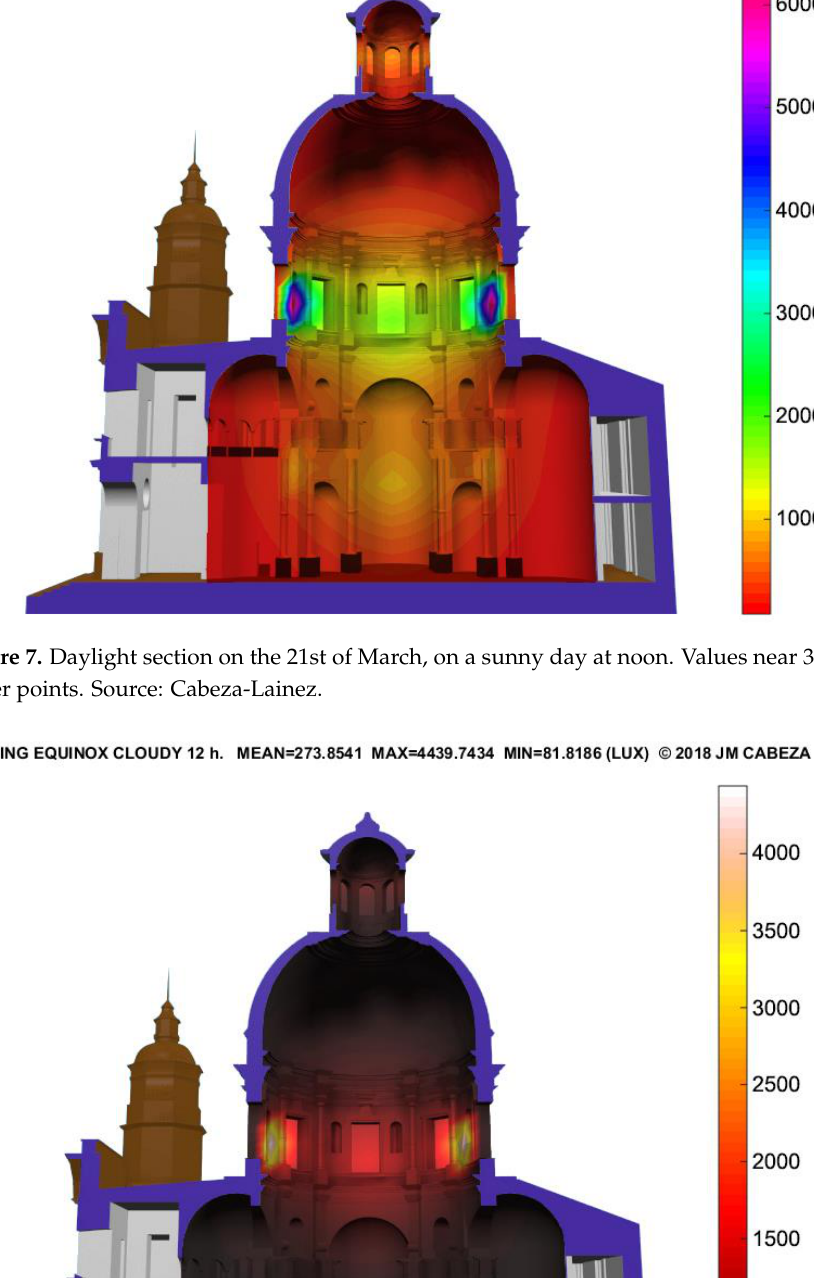
Figure 6. Summer standard sunny day. Reversed in the vertical axes at 8.45 h. Source: Authors.